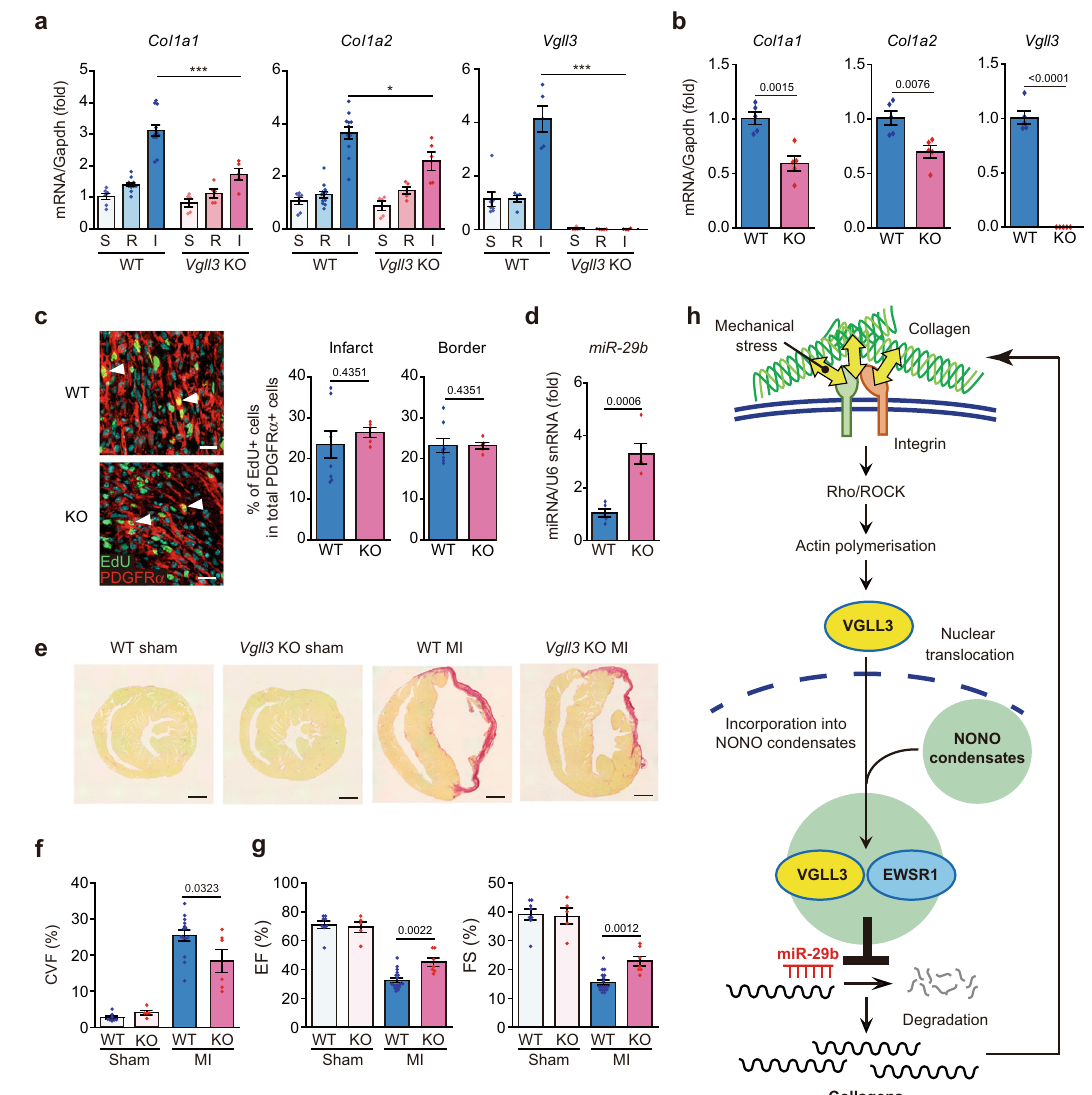
Fig. 6 | Vgll3 de fi ciency in mice attenuates cardiac fi brosis and impairs cardiac dysfunctions after myocardial infarction. a mRNA levels of Col1a1 , Col1a2 and Vgll3 insham(S)-operatedventricles,andintheremote(R)andinfarcted(I)areasof wild-type (WT) and Vgll3 knock-out (KO) mouse hearts, 3 days after MI (WT: S/R/I, n =7/12/12;KO:S/R/I, n =5/5/5). b mRNAlevelsof Col1a1 , Col1a2 and Vgll3 incardiac myo fi broblasts isolated from WT and Vgll3 KO mouse hearts, 3 days after MI (WT: n =5; KO: n =5). c Immunostaining images of heart sections of WT and Vgll3 KO miceonday4afterMI.EdUwereinjectedintothemice24hbeforesampling.White arrowheadsindicateEdU+andPDGFR α + fi broblasts.ThepercentagesofEdU+cells in total PDGFR α + fi broblasts of border or infarcted area are shown in the graph (WT: n =8;KO: n =5). d miR-29blevelsininfarctedareasofWTand Vgll3 KOmouse hearts, 3 days after MI ( n =5 each). e Images of heart sections of WT and Vgll3